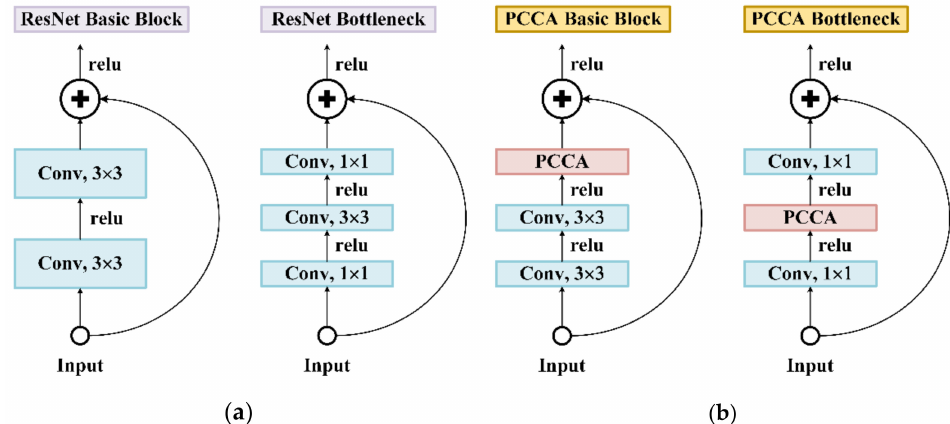
Figure 7. The architecture of residual blocks. ( a ) denotes the standard basic block and bottleneck of ResNet and ( b ) denotes our proposed PCCA basic block and PCCA